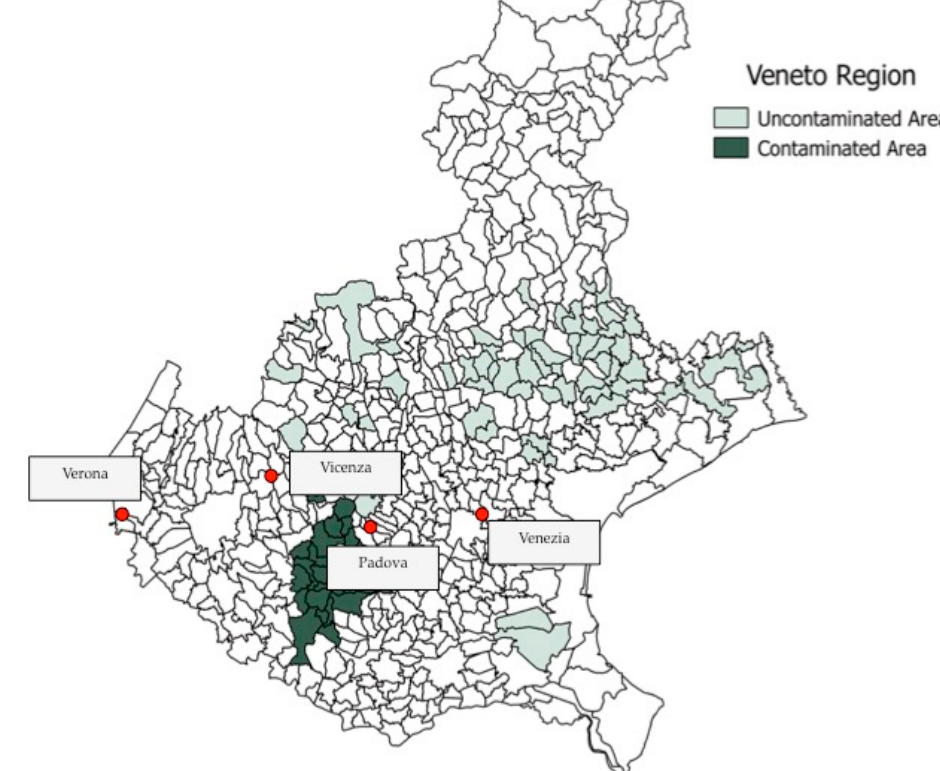
Figure 2. Contaminated (in dark grey) and uncontaminated (in light grey) municipalities on the basis of the Italian National Health Institute (ISS) performance limits in drinking water in the Veneto region. In many municipalities (in white) no analyzes were carried out [120].